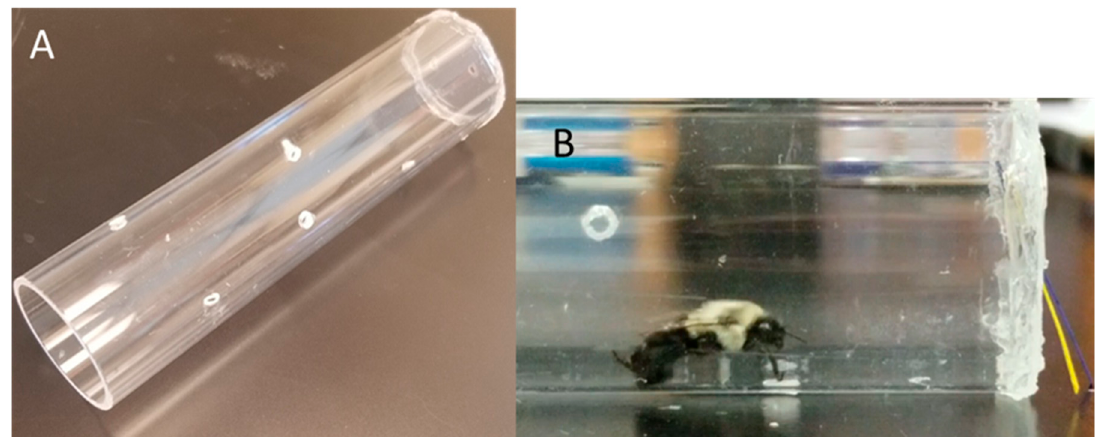
Figure 1. ( A ) The modified tubes used for the behavioral assay. ( B ) An adult bumble bee during the behavioral assay presented with both colors of paper.